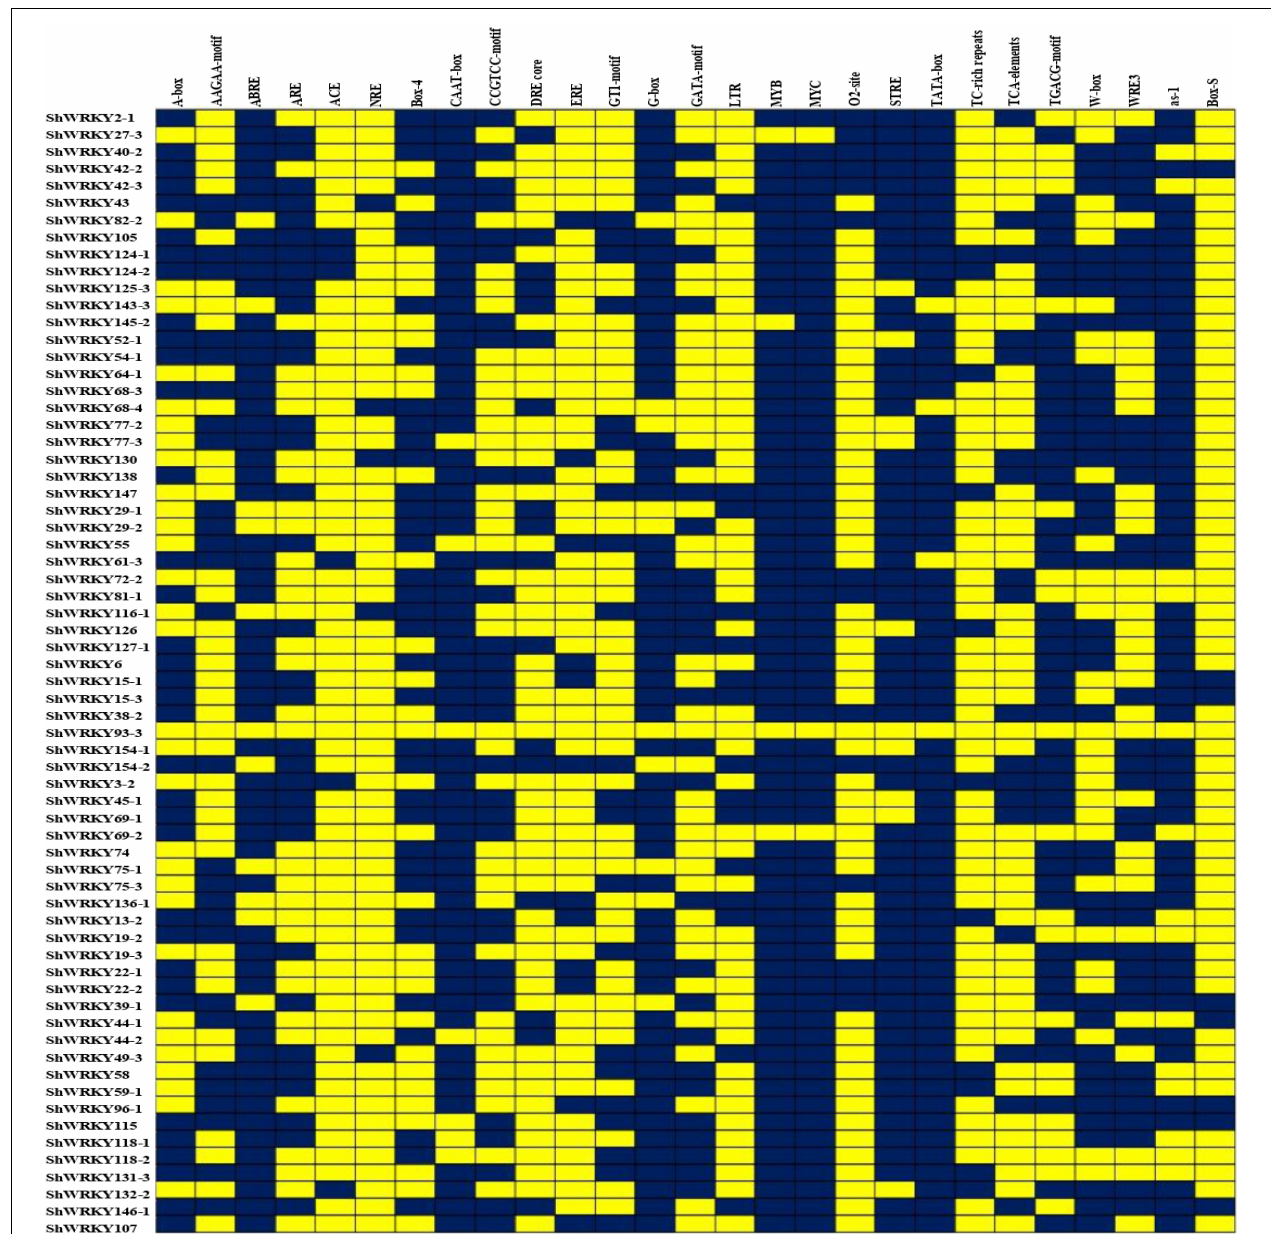
FIGURE 3 | Heatmap of cis -regulatory elements in the ShWRKY genes. Blue: Present, Yellow: Absent.